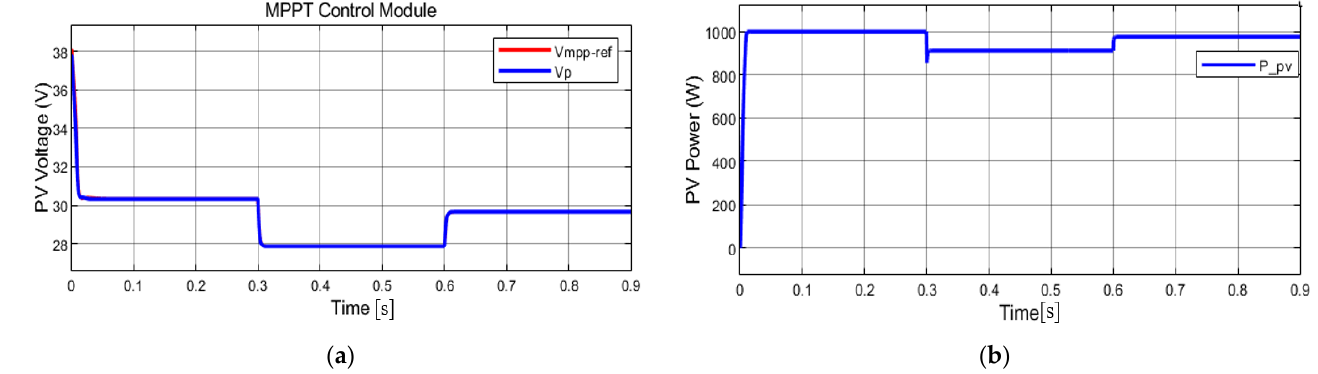
Figure 12. MPPT module performance for constant solar irradiation: ( a ) PV voltage; ( b ) PV output power.